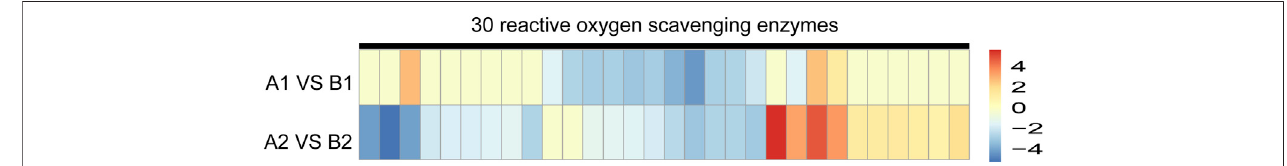
FIGURE 5 | Expression analysis of DEPs in ROS scavenging enzymes of AL18A and AL18B at two anther development stages.